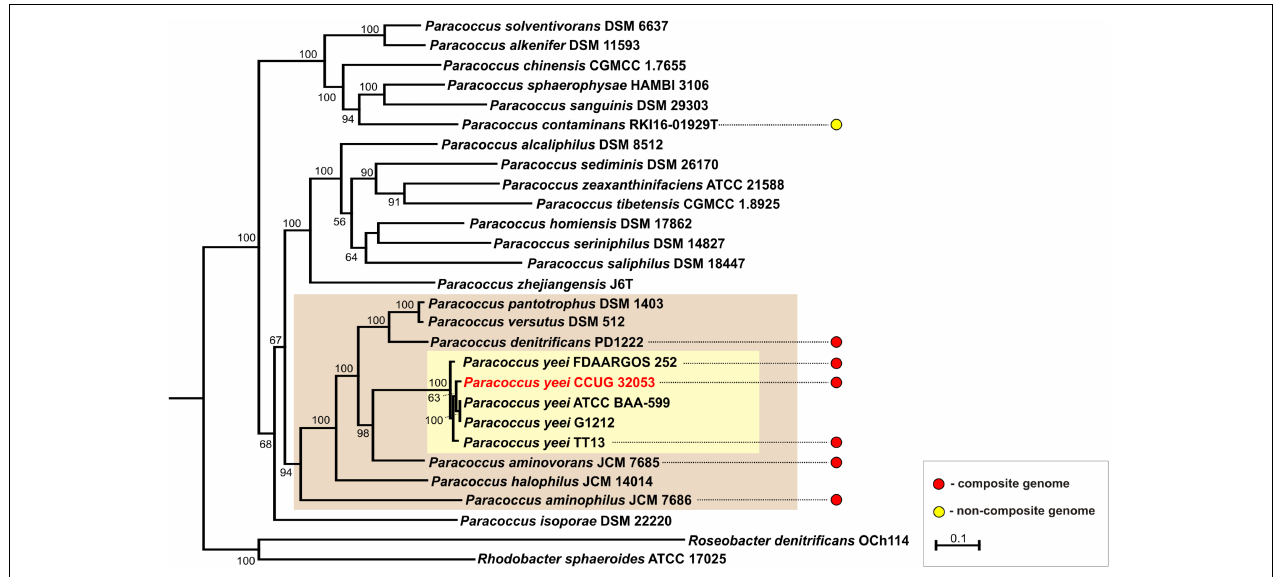
FIGURE 4 | Phylogenetic tree of the genus Paracoccus based on concatenated nucleotide alignment of seven core genes ( atpD , dnaA , dnaK , gyrB , recA , rpoB, and thrC ). Homologous genes of Rhodobacter denitrificans OCh 114 and Roseobacter sphaeroides ATCC 17025 were used as an outgroup. The tree was constructed by applying the Maximum Likelihood algorithm. Statistical support for the internal nodes was determined by 2000 bootstrap replicates and values of ≥ 50% are shown. The scale bar represents 0.1 substitutions per nucleotide position. The clades of Paracoccus spp. strains containing multipartite genomes and of P. yeei strains were shown on beige and yellow background,